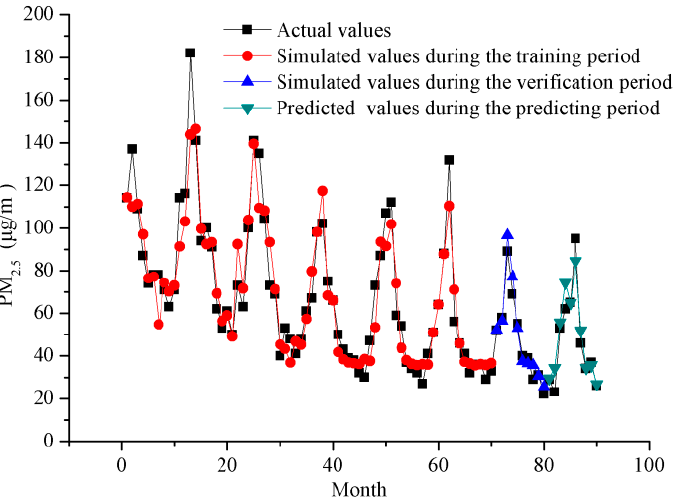
Figure 8. Training, verification, and prediction of monthly average PM 2.5 concentration in Liaocheng